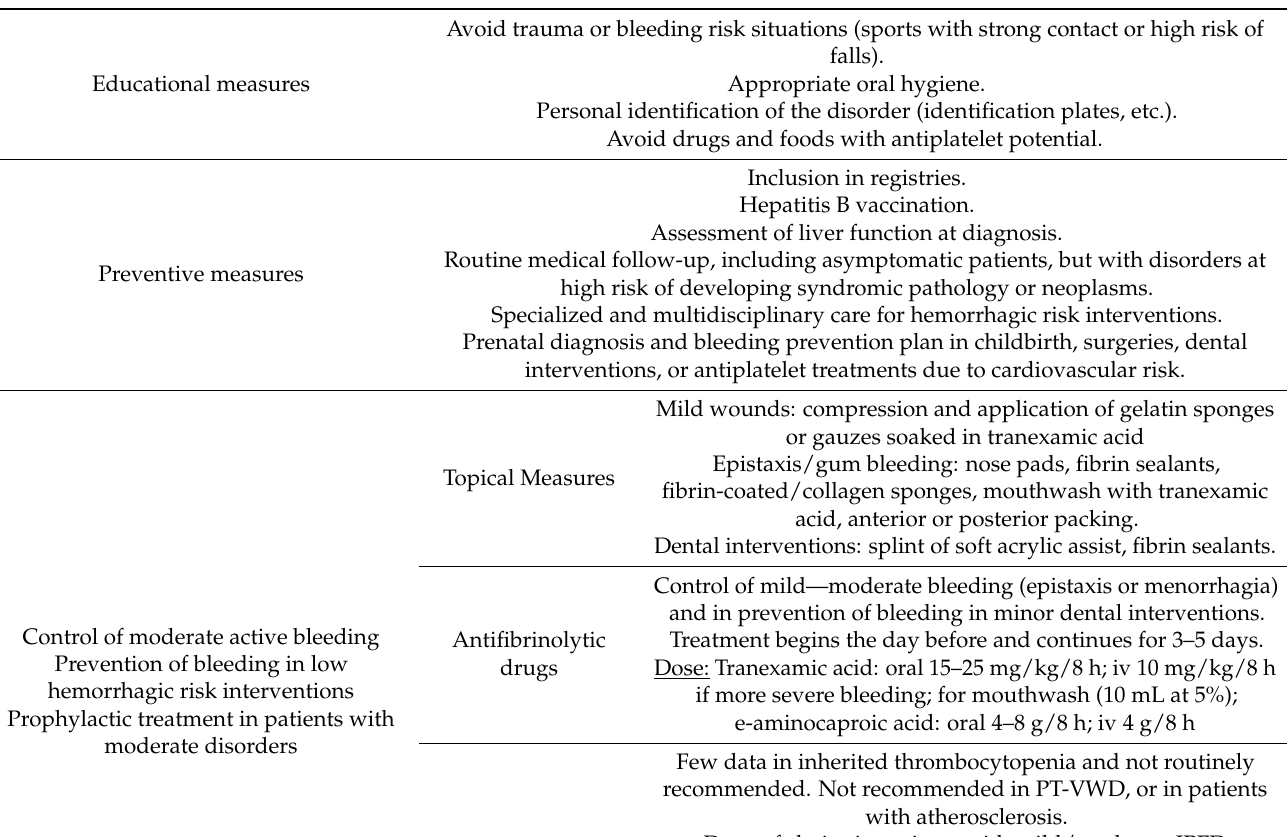
Table 1. General measures and treatment options in the management of patients with inherited platelet disorders, with a special focus in those with inherited